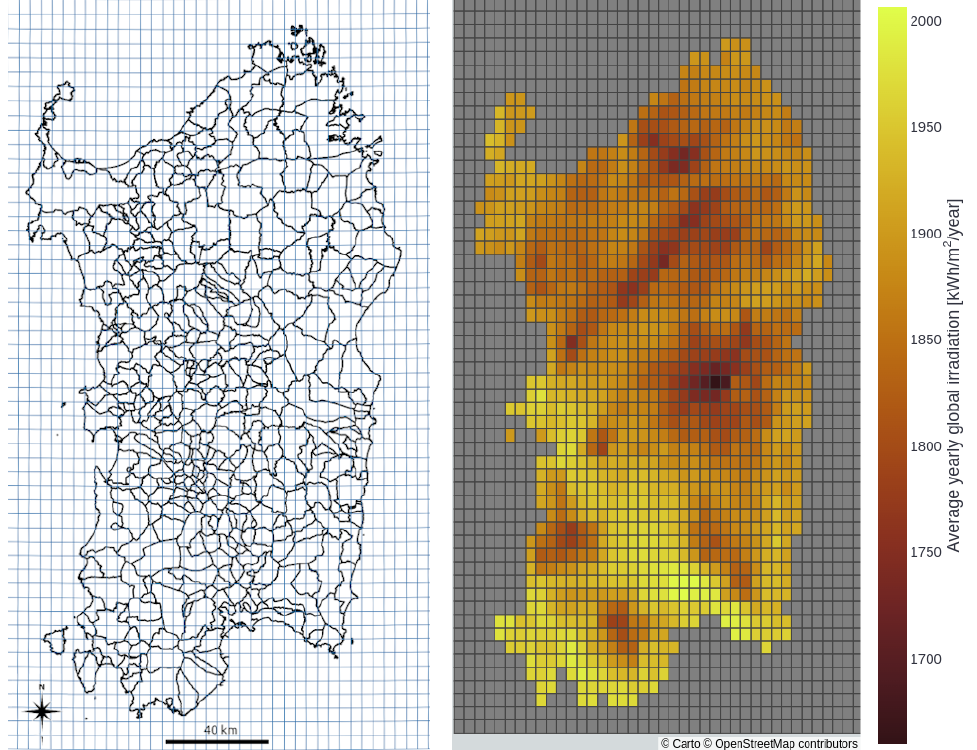
Figure 4. The island of Sardinia represented by the territorial boundaries of its municipalities (in black), ( left ) superimposed on the grid of sectors of size 0.05 ◦ (in blue) of the PVGIS-SARAH2 database and ( right ) by the average annual global irradiance on a 1 m 2 surface oriented to the south and inclined by 20 ◦